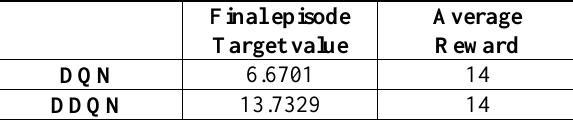
Table 3: Comparison of DQN with